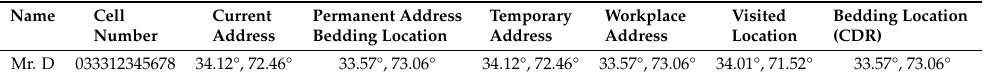
Table 7. Information gathered from the proposed